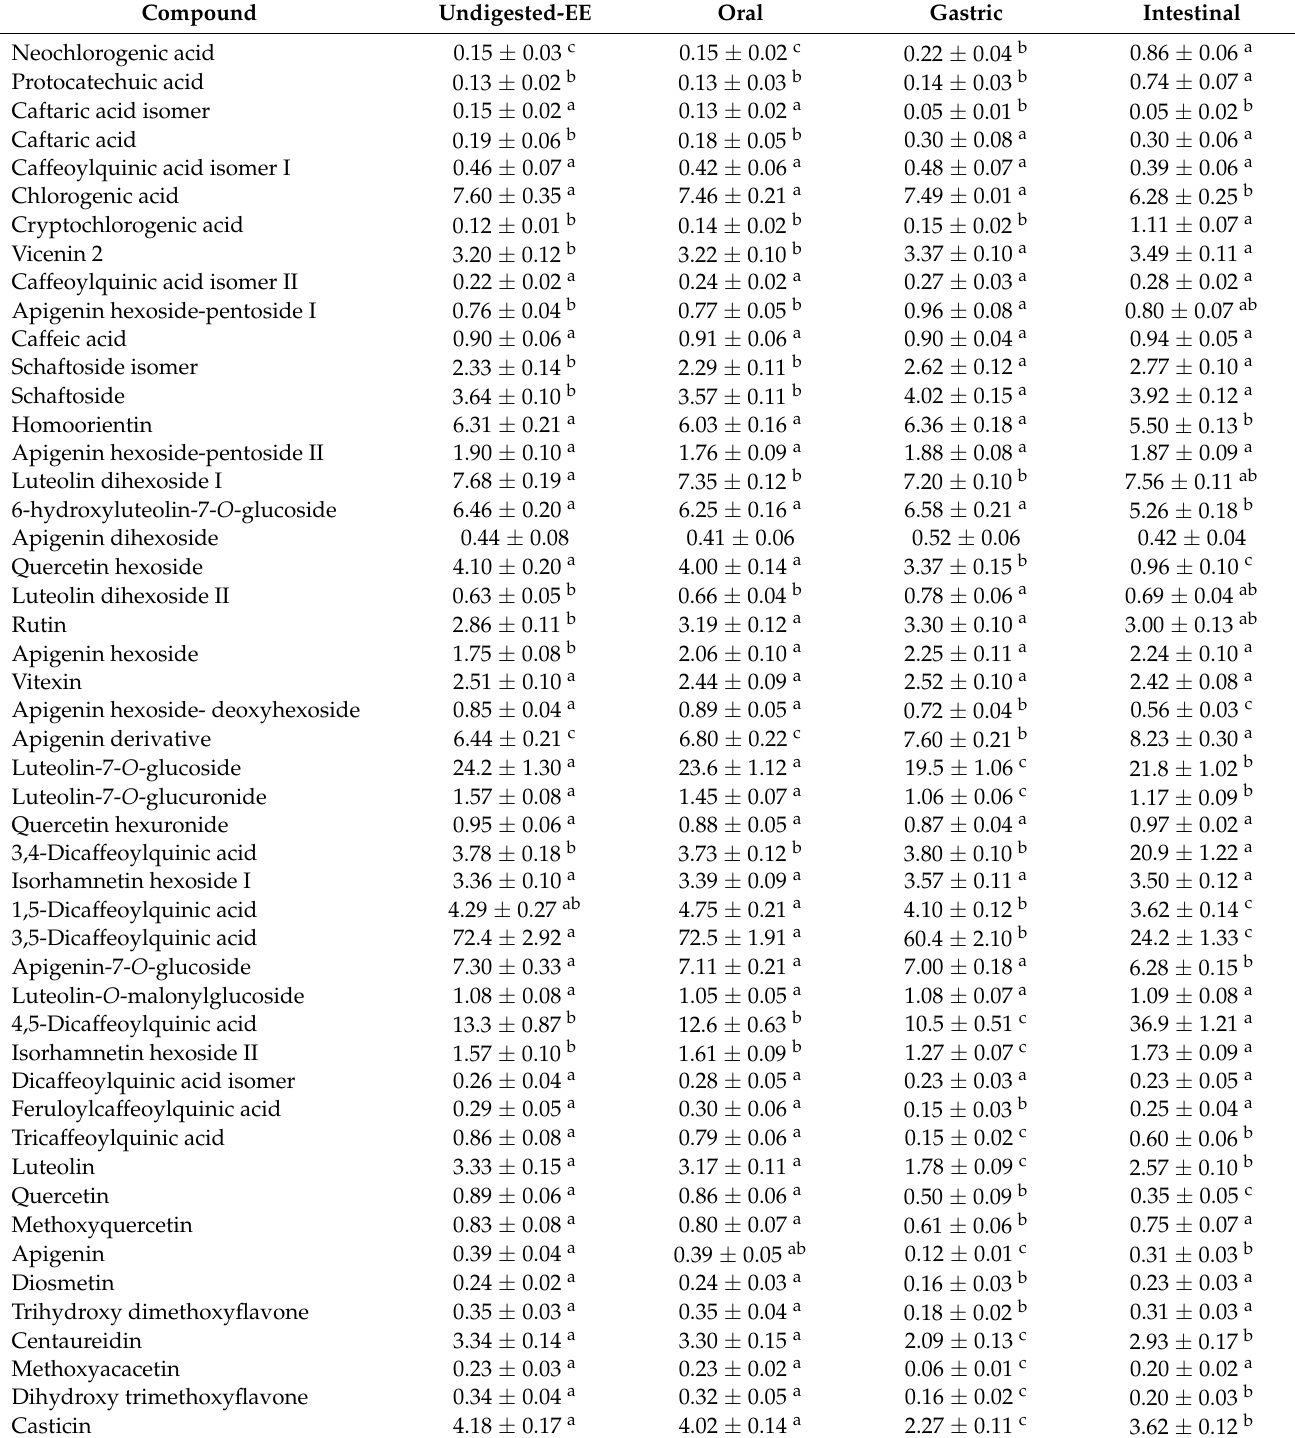
Table 2. Phenolic compounds (mg/g extract) of yarrow enriched-extract (EE) before and after oral, gastric and intestinal digestion